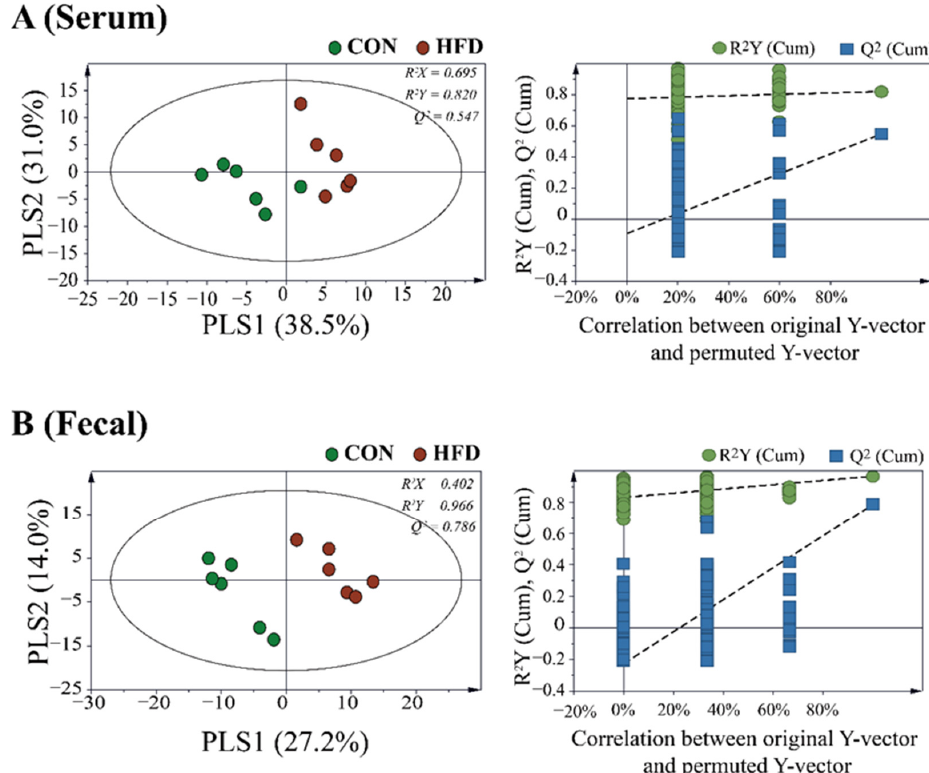
Figure 4. Supervised partial least squares discriminant analysis (PLS − DA) score plot derived from the GC − MS data of ( A ) serum and ( B ) fecal samples of HFD and control groups. Permutation tests with 200 iterations were performed to validate the goodness of fit of the original model.